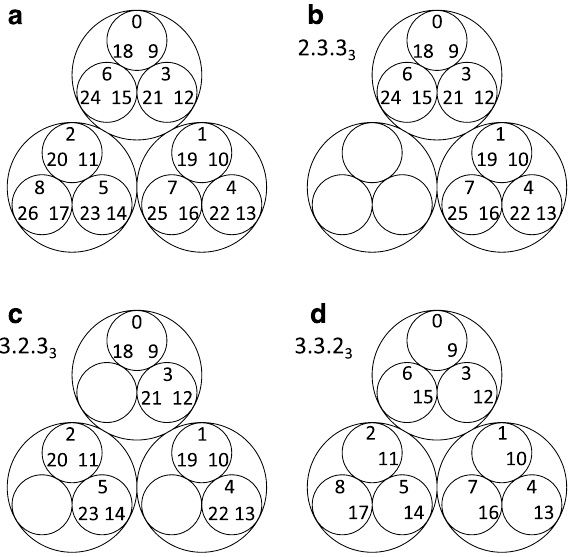
Figure 1. Hierarchical structures of natural numbers. ( a ) Circular tree-map for the hierarchical structure of 3-adic numbers. ( b–d ) The digit notations specify the hierarchical arrangements.